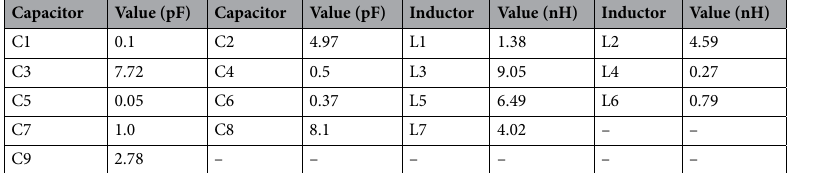
Table 2. Circuit components and values of the primary equivalent